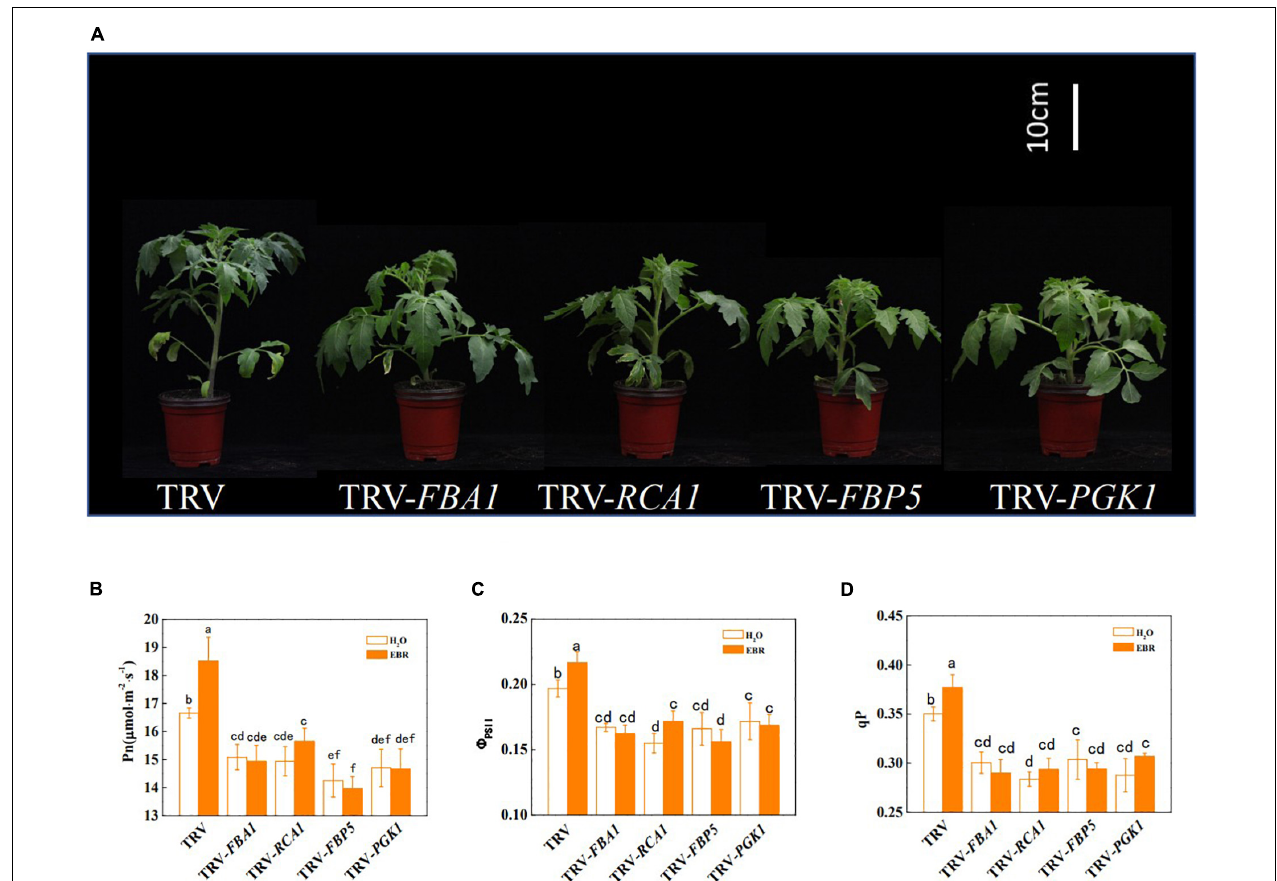
FIGURE 5 | Influence of FBA1, RCA1, FBP5, and PGK1 silencing on plant growth and photosynthesis in tomato plants. (A) The phenotype of FBA1-, RCA1-, FBP5-, and PGK1 -silencing plants. (B) Net photosynthetic rate (Pn). (C) The actual quantum yield of PSII ( (cid:56) PSII ). (D) Photochemical quenching coefficient (qP). Five-week-old plants were used for photographs taken and parameters measured in this analysis. Plants, which were infected with an empty TRV2 vector named TRV, were used as controls here. EBR (200 nM) was applied at 8:00 in the morning. For (B–D) , values were measured 24 h after EBR treatment. Data are the means ± SD of four biological replicates. Different letters represent significant differences ( p < 0.05) according to Tukey’s test. Three independent experiments were performed with similar results.